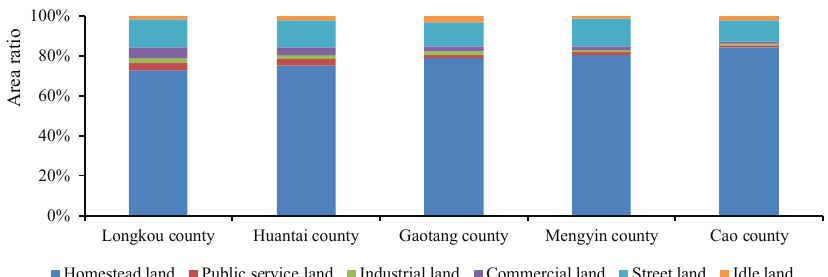
Figure 6. The mean statistics of the proportion of rural residential land types in different areas.